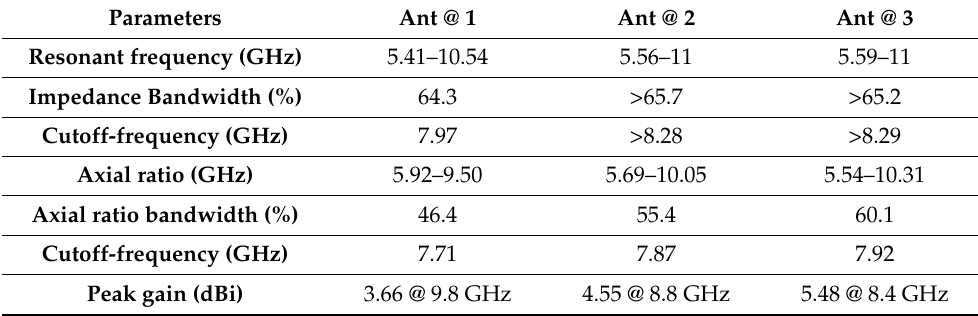
Figure 6. Scattering and axial ratio results for Ant @ 1, Ant @ 2, and Ant @ 3 ( a ) S-Parameters and ( b ) Axial ratio. Table 4. Comparative analysis of different antenna design stages. Table 4. Comparative analysis of different antenna design stages.